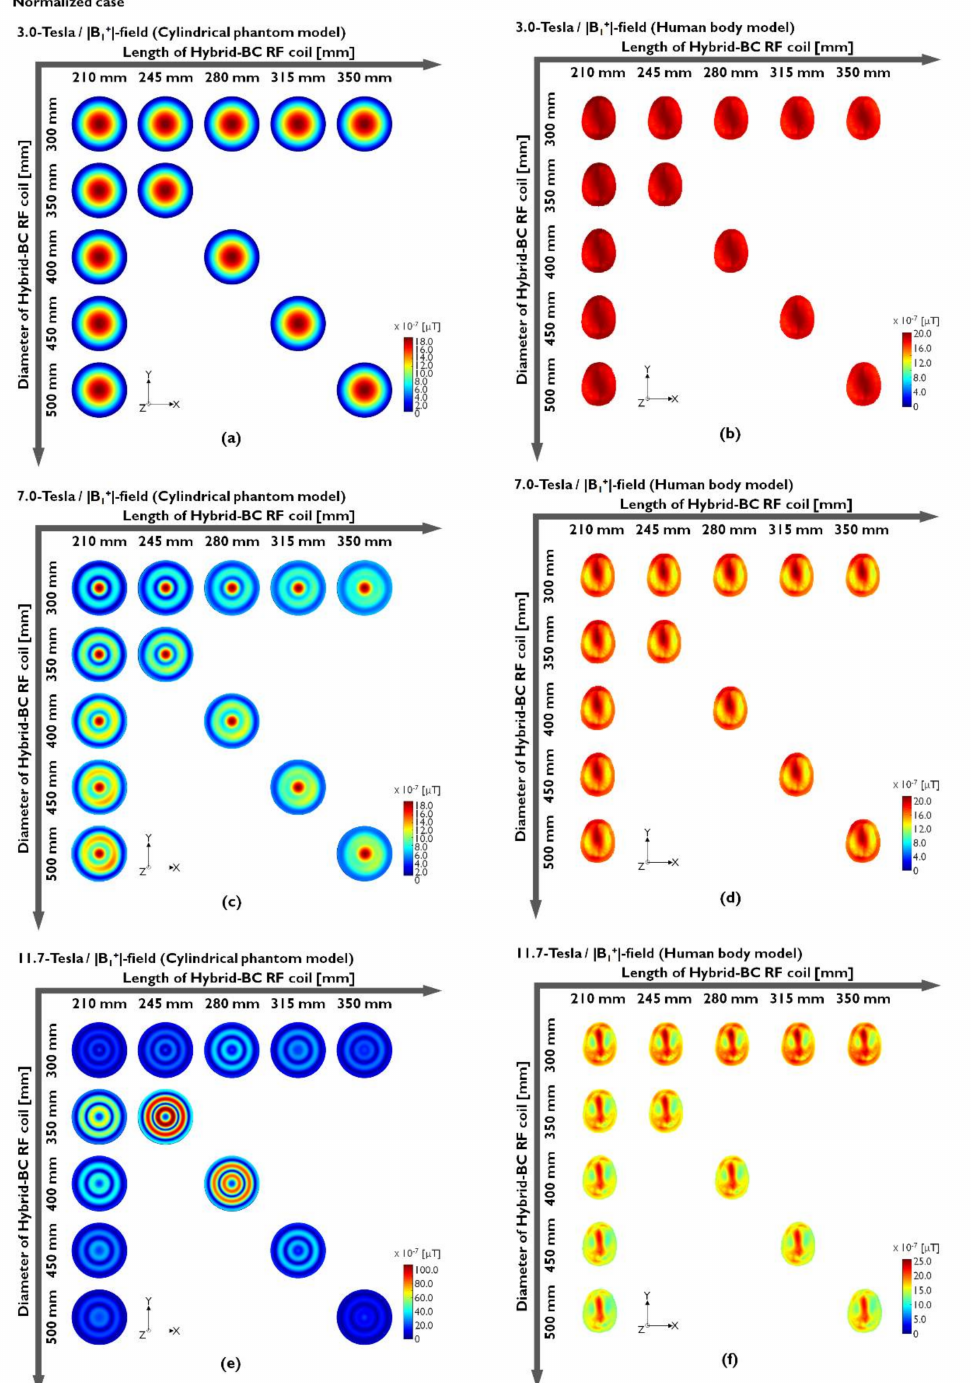
Figure 5. Normalized |B 1 + |-field distribution obtained when using a cylindrical phantom model ( a , c , e ) or a human body model ( b , d , f